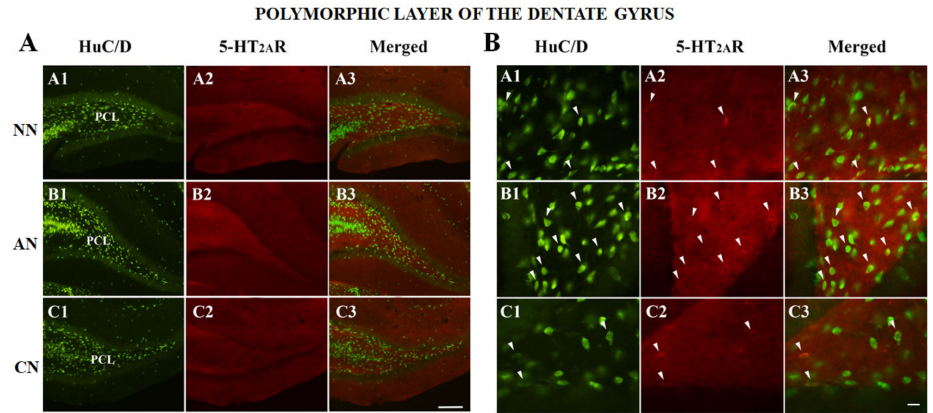
Figure 4. ( A ) Colocalization of the HuC / D with 5-HT 2A receptor (5-HT 2A R) in the dentate gyrus (polymorphic cell layer) of naïve nicotine (NN) (A1–A3), acute nicotine (AN) (B1–B3) and chronic nicotine (CN) (C1–C3) rats. Double immunofluorescence images showing HuC / D in green (left column pictures; A1, B1 and C1), 5-HT 2A R in red (middle column pictures; A2, B2 and C2), and colocalization of HuC / D with 5-HT 2A R in yellow (right column merging pictures; A3, B3 and C3). Note the high 5-HT 2A R immunoreactivity in the polymorphic cell layer of acute nicotine rats. See text and Table